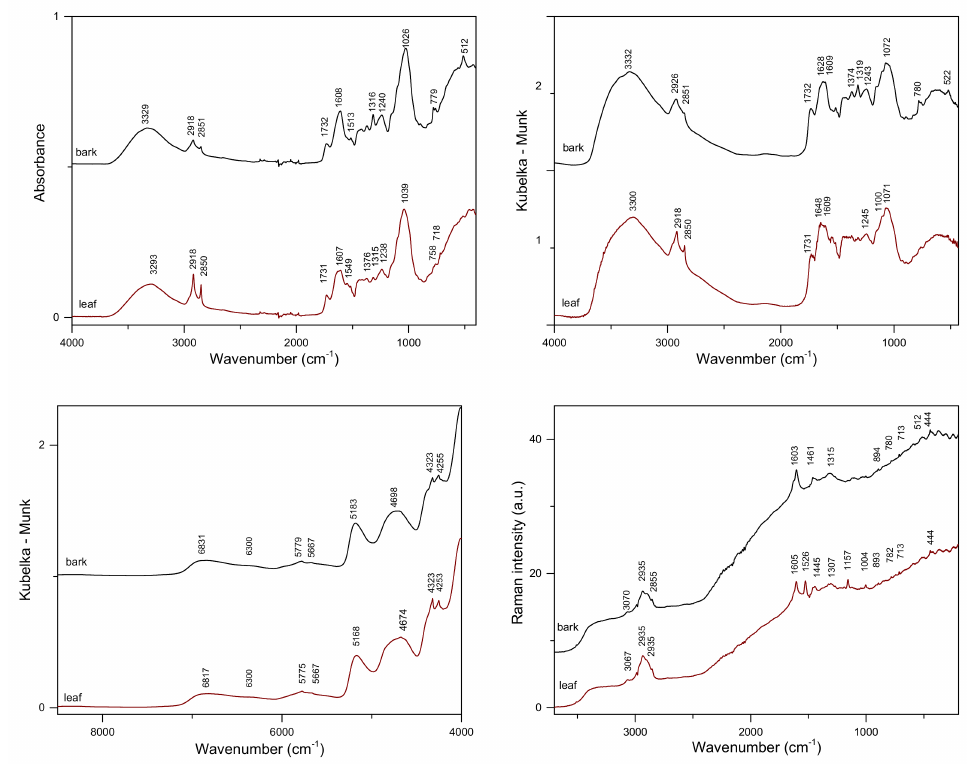
Figure 3. Vibrational spectra of poplar bark and leaves: top panel—ATR ( left ) and DRIFTS ( right ) and bottom panel—NIR ( left ) and Raman ( right